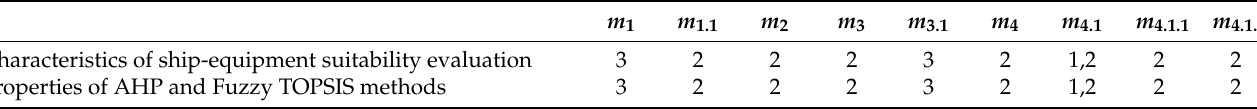
Table 1. Problem characteristics and method